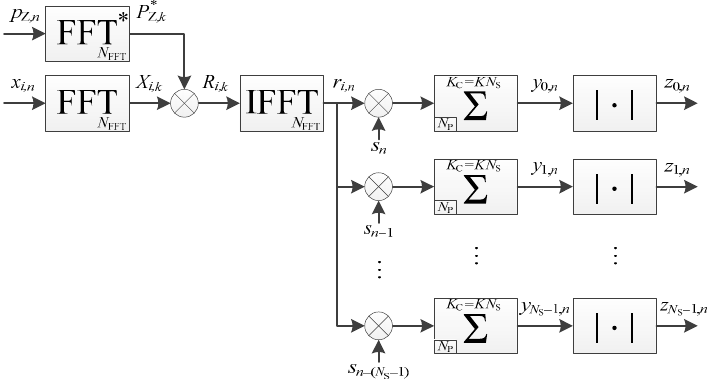
Figure 4. Implementation of a pilot channel acquisition, with coherent integration only, in a parallel way (timing diagram available in Figure 5).